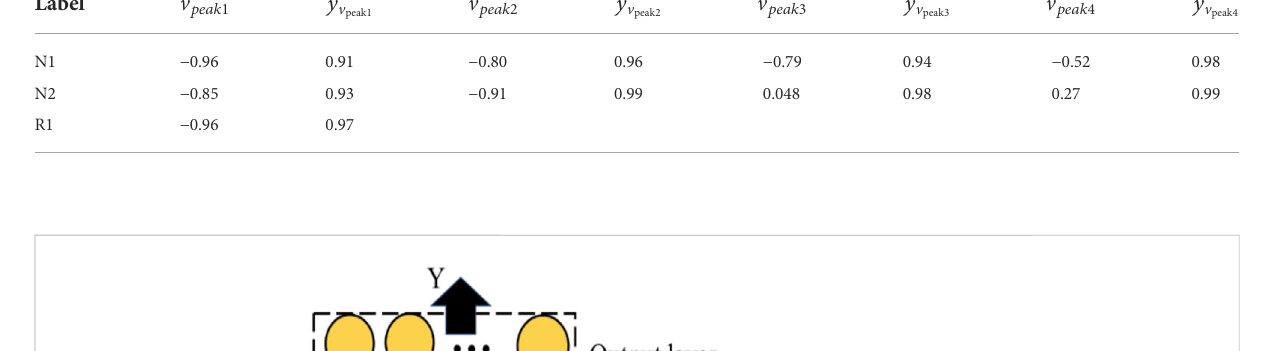
TABLE 2 The correlation coef fi cient between preselected features and the battery SOH. Label